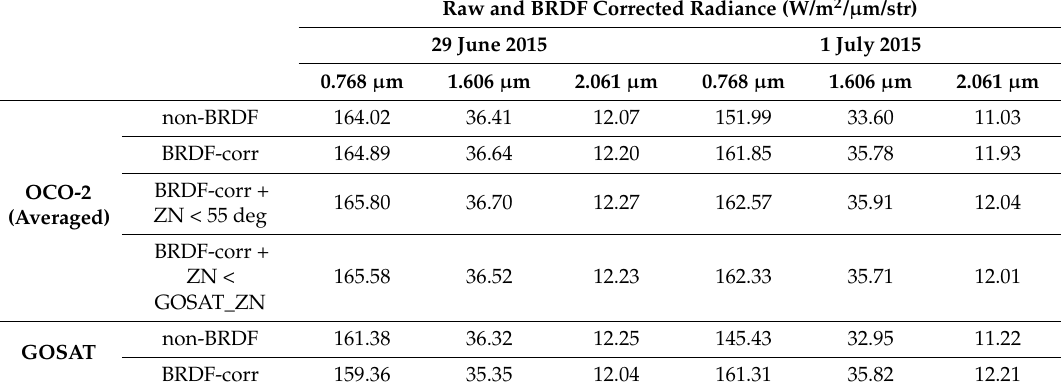
Table 3. The averaged GOSAT and OCO-2 spectral radiance during the RRV target observation on 29 June 2015 and 1 July 2015 at wavelengths of (a) 0.768 µ m; (b) 1.606 µ m and (c) 2.061 µ m with the selected sensor zenith angles (55 degree and GOSAT satellite zenith angle). The GOSAT satellite zenith angles are 38 degrees on 29 June 2015 and 28 degrees on 1 July 2015. In this Table, ZN and non-BRDF, BRDF-corr are sensor zenith angle, radiance with BRDF correction and without BRDF correction, respectively.